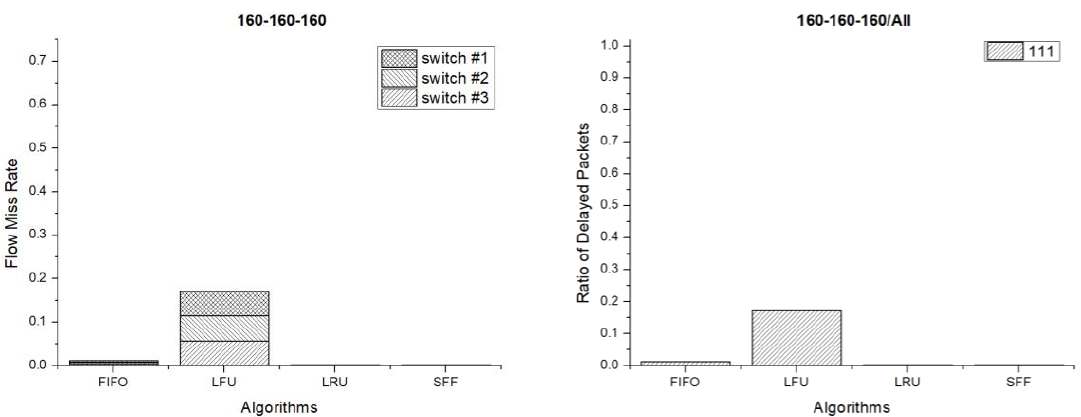
Figure 10. Experiment results with 160-160-160 flow table size.